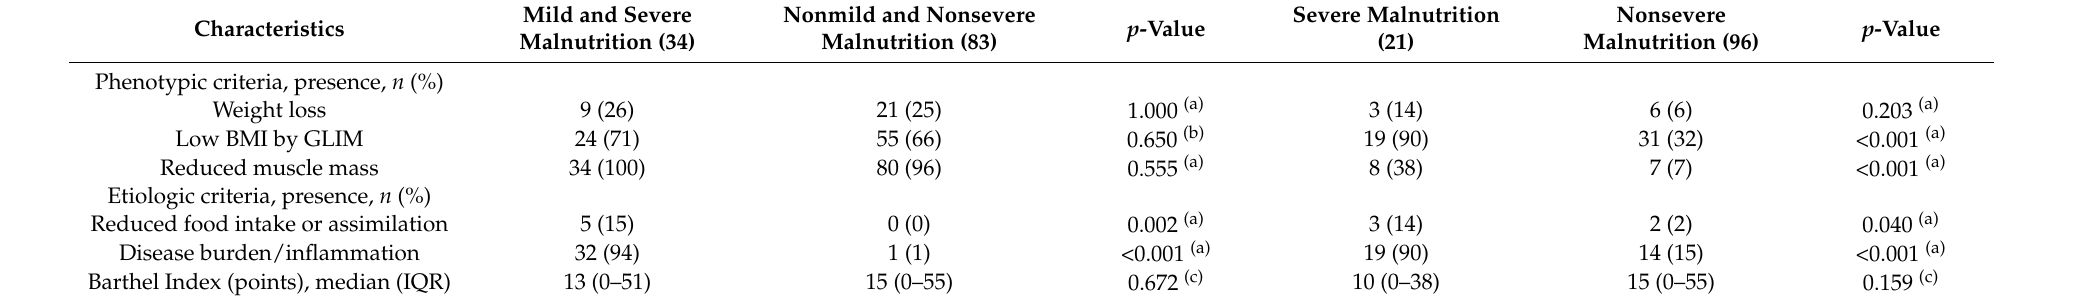
Table 2. Nutritional characteristics based on the GLIM components in residents with and without malnutrition and the Barthel index.